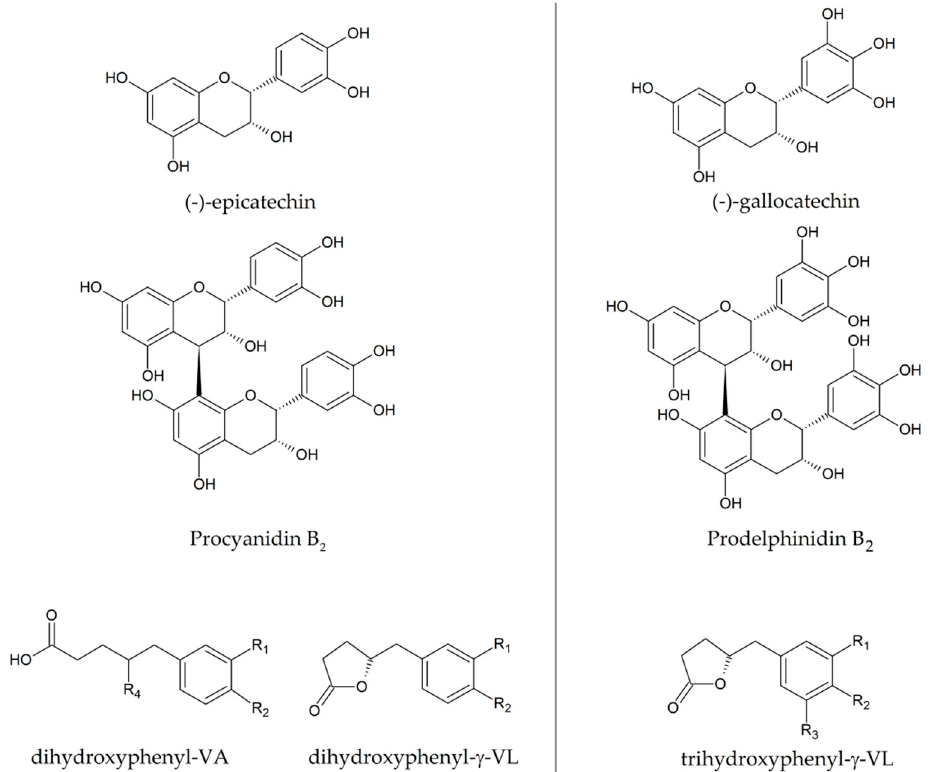
Figure 1. Left: structures of (-)-epicatechin, the dimer procyanidin B 2 , a dihydroxyphenyl- γ - valerolactone (VL) and the related phenyl-valeric acid (VA). Right: structure of the (-)-gallocatechin, its dimeric form prodelphinidin B 2 and a trihydroxyphenyl-VL. Substituents (R 1 , R 2 , R 3 ) can be hydroxyl groups, sulfate, methoxy, or glucuronic acid, while R 4 can be hydrogen (yielding 5-(3’,4’-dihydroxyphenyl)VA) or hydroxyl group (yielding 4-hydroxy-5-(3',4'-dihydroxyphenyl)VA).